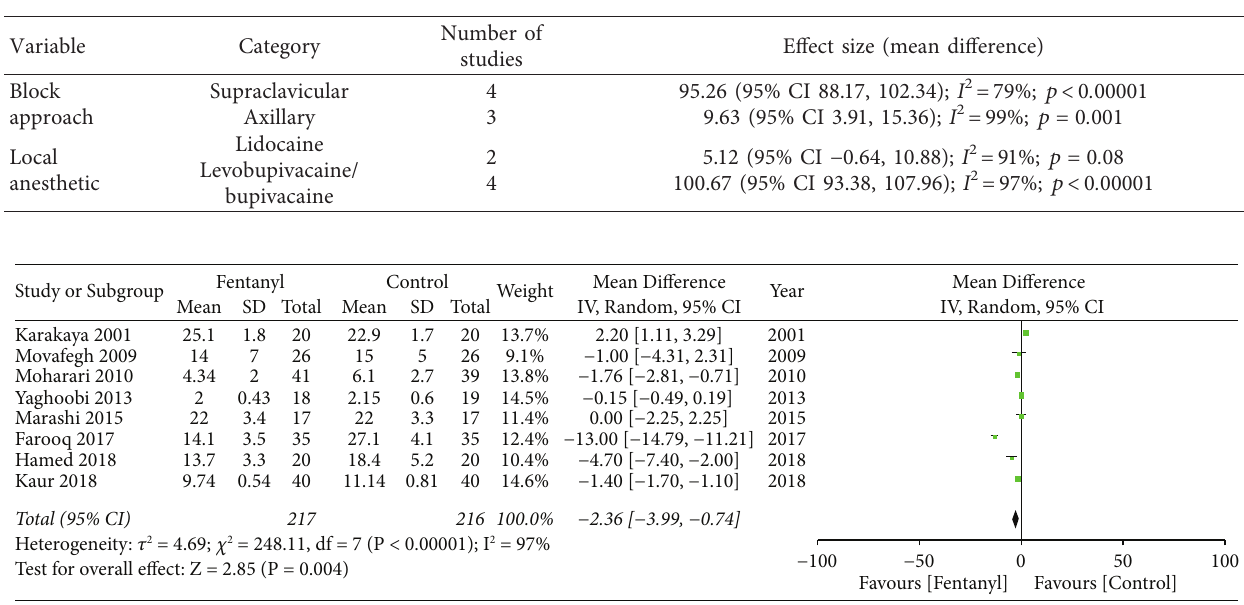
Figure 5: Meta-analysis of onset of motor anesthesia between fentanyl and control groups.